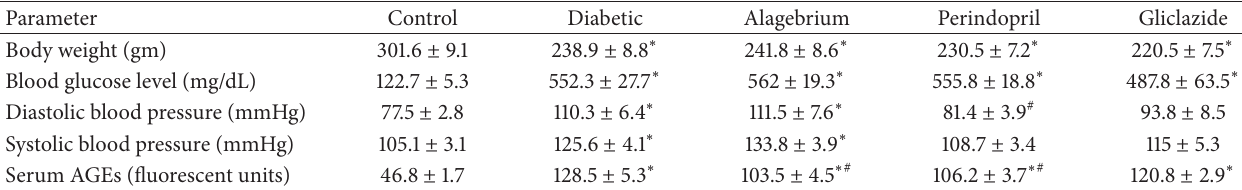
Table 1: Effects of alagebrium (10mg/kg), perindopril (4mg/kg), or gliclazide (10mg/kg) on body weight, blood glucose level, blood pressure (diastolic and systolic), and serum AGEs level in STZ-induced diabetes in rats. Data are presented as mean ± SEM ( 𝑛 = 6 ).